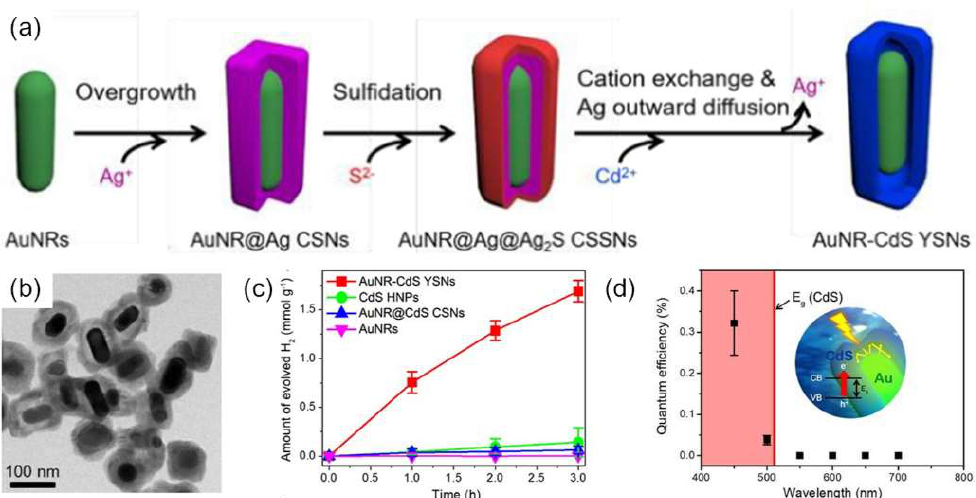
Figure 2. ( a ) Schematic illustrating the synthesis route of Au–CdS yolk–shell nanostructures. ( b ) Transmission electron microscopy (TEM) image of Au–CdS yolk–shell nanostructures. ( c ) Rate of evolved hydrogen with different catalysts. ( d ) Hydrogen evolution activity of Au–CdS yolk–shell hybrids as a function of excitation wavelength. Inset shows the schematic illustration of the